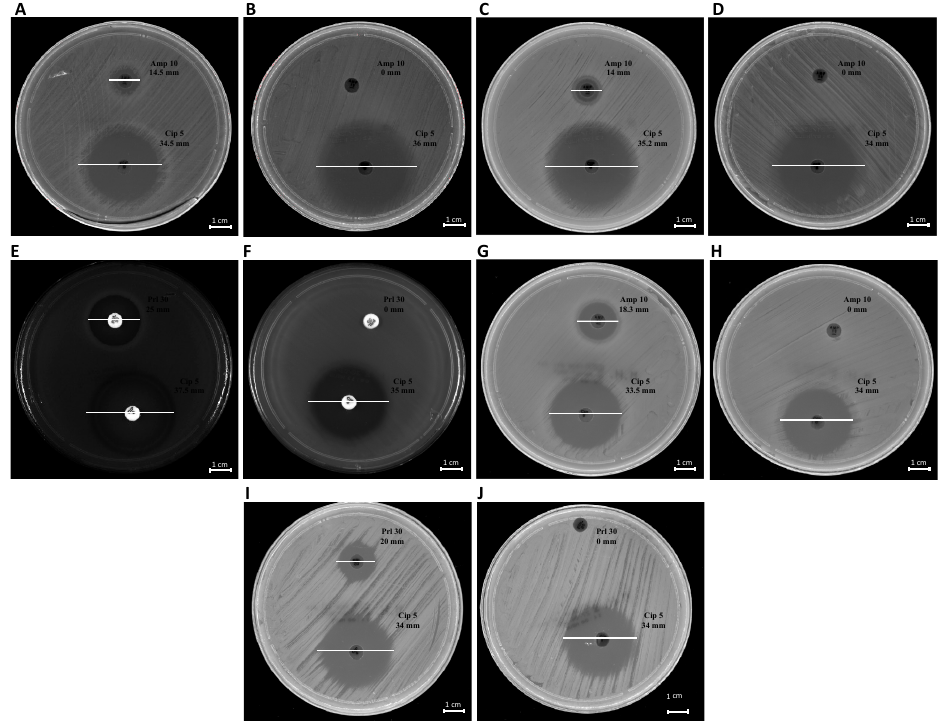
Figure 8. Antibiotic susceptibility of bacteria to ß-lactams. K. pneumoniae pre- and post-OMVs treatment ( A , B ); E. coli pre and post-OMVs treatment ( C , D ); P. aeruginosa pre- and post-OMVs treatment ( E , F ); S. enterica pre- and post-OMVs treatment ( G , H ); B. cepacia pre- and post-OMVs treatment ( I , J ).